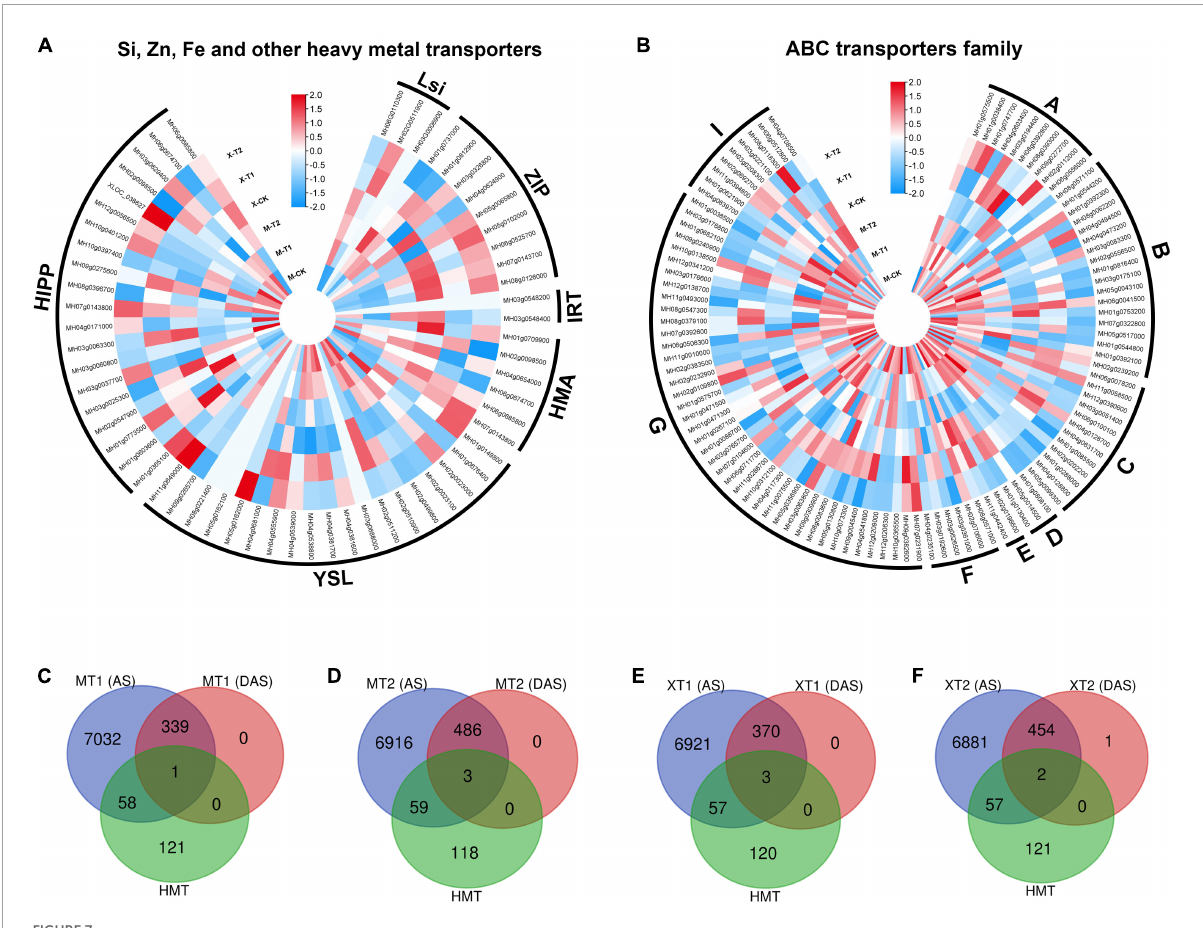
FIGURE7 Silicon, Zinc, Iron and other have metals transporters genes identified in DEGs in Meixiangzhan-2 (M) and Xiangyaxiangzhan (X) cultivars in response to different levels of Zn treatment. Blue, white, and red indicate low, no and high gene expression, respectively (A,B) . While, Venn diagram representing the overlap between AS sites, DAS events and HMTs in response to different doses of Zn in Meixiangzhan-2 (A,B) and Xiangyaxiangzhan (C–F)